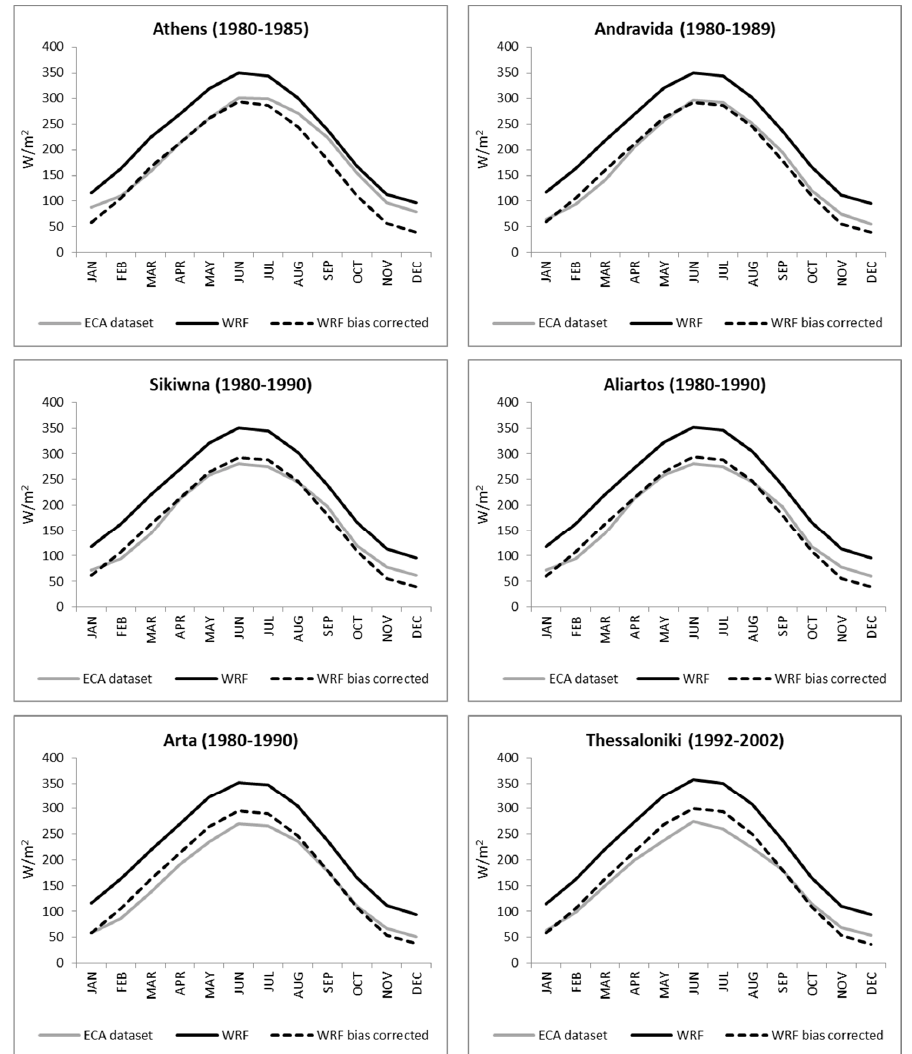
Figure 3. Comparison chart of monthly Global Horizontal Irradiation (GHI) (W/m 2 ) climatology for the selected stations.